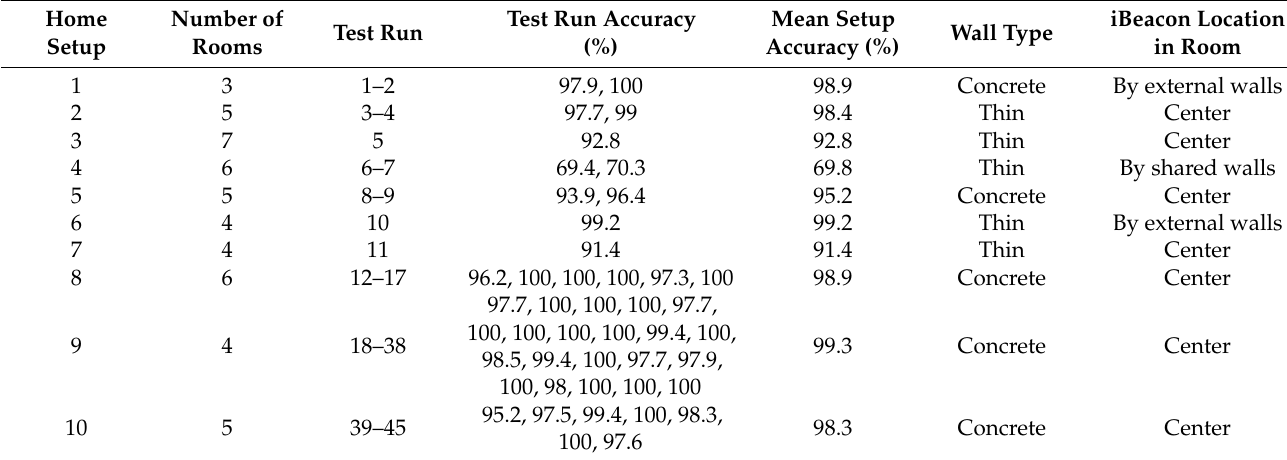
Table 1. Home setups in our internal study with healthy volunteers, number of rooms (matching the number of iBeacons deployed in each home setup) and room estimation accuracy results for different home setups. Note than thin wall type is meant to include both wooden and plaster walls.